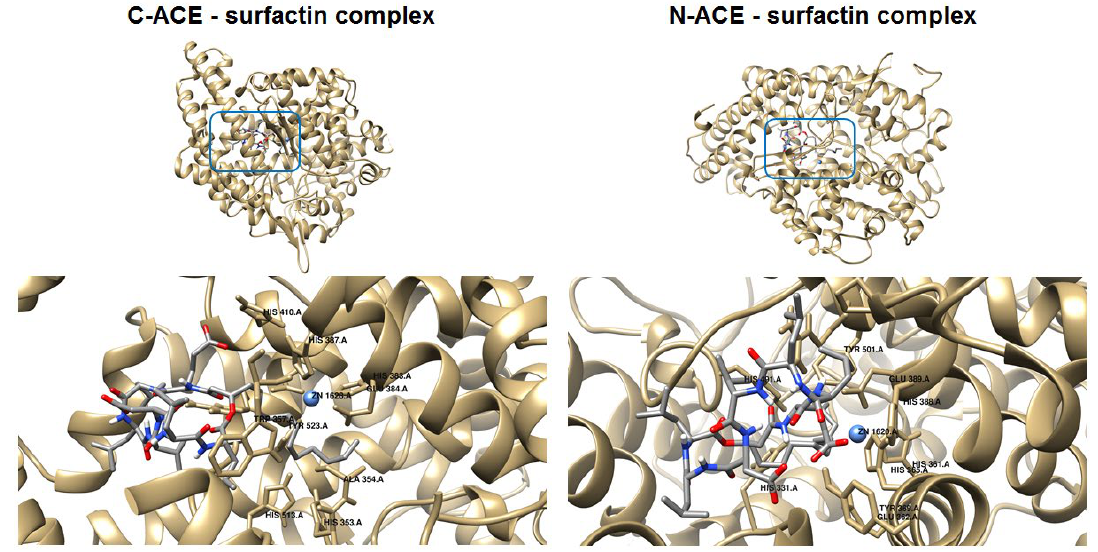
Figure 4. Binding mode of surfactin to C-ACE and N-ACE domains.